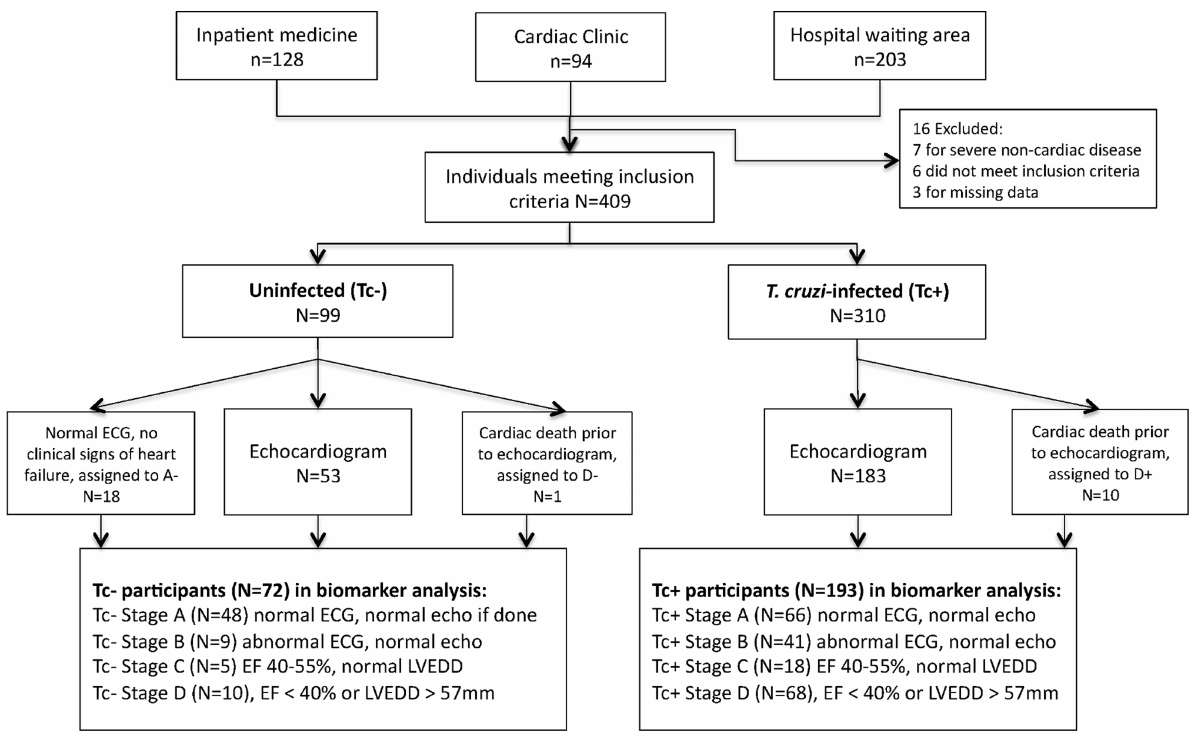
Figure 1. Study enrollment and staging classification.